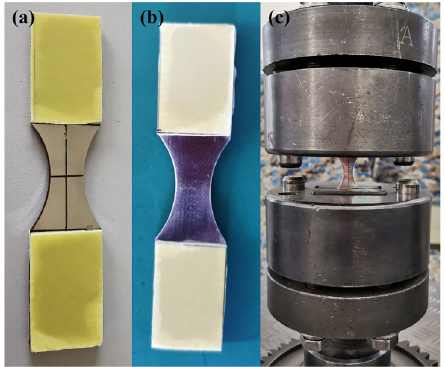
Figure 2. ( a ) High -cycle tension–tension fatigue test specimen with UN-LSP; ( b ) High-cycle tension–tension fatigue test specimen with LSP; ( c ) High-cycle tension–tension fatigue test diagram.